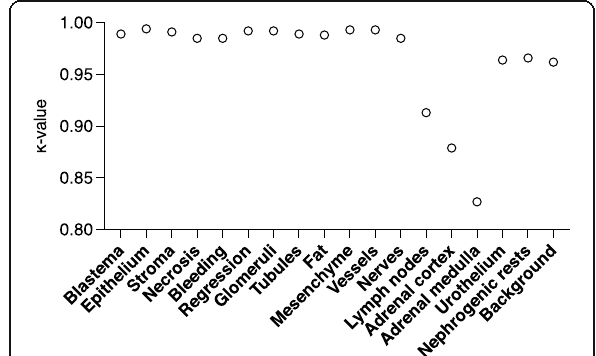
Fig. 2 Interobserver agreement per annotated tissue element for all six